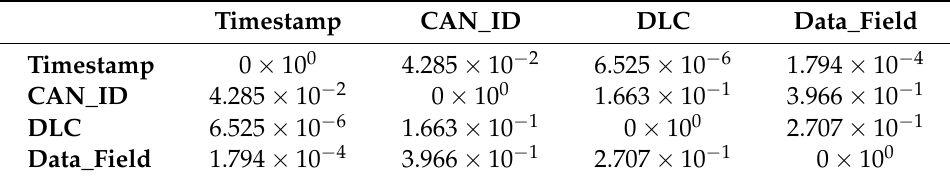
Table 3. Pearson product–moment correlation between different